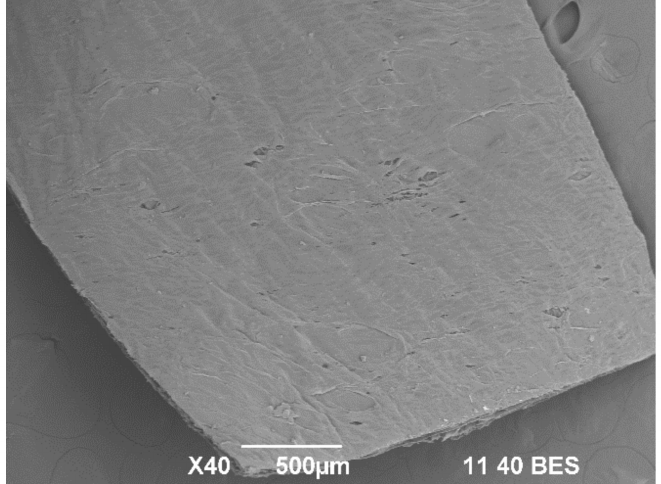
Figure 11. F3 (InterCollagen Guide) membrane SEM